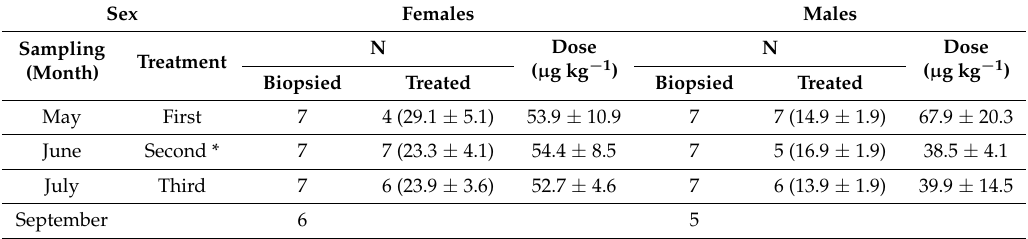
Table 2. Number and mean ( ± SD) oocyte diameter ( µ m) of biopsied greater amberjack (N), and number, mean weight ( ± SD) and dose of GnRHa ( µ g kg − 1 body weight) of implanted greater amberjack at each treatment/sampling time. All treated fish (N) were given a GnRHa implant, and slight variations in the